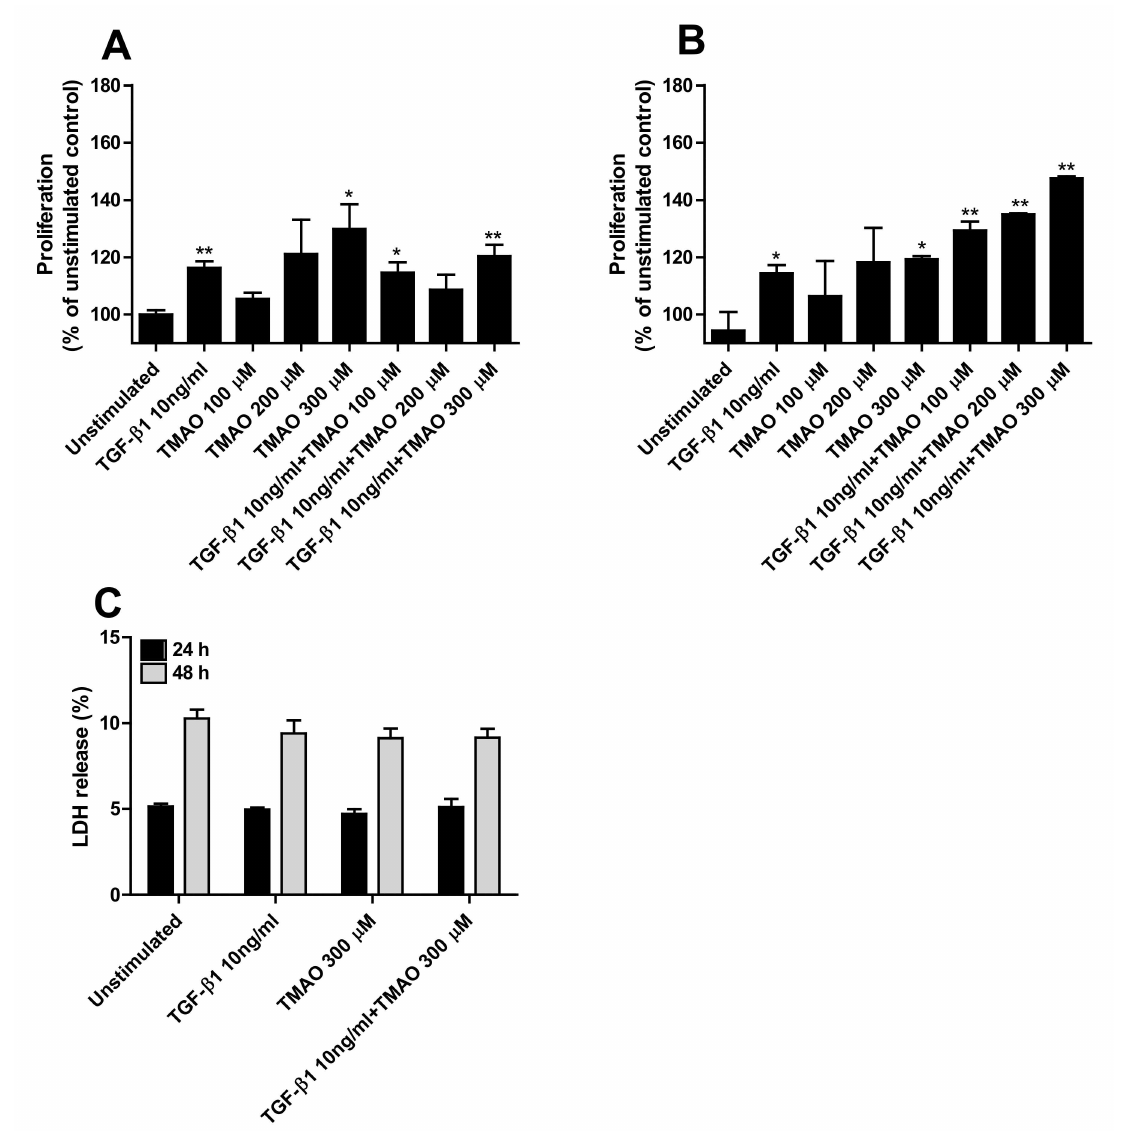
Figure 2. TMAO induces renal fibroblast proliferation. Renal fibroblasts were stimulated with 100–300 µ M TMAO and 10 ng/mL TGF- β 1 for 24 h ( A , C ) or 48 h ( B , C ) and proliferation ( A , B ) or LDH release ( C ) were evaluated. Proliferation is presented as % of unstimulated control. LDH release is presented as % of total LDH. Data are presented as mean ± SEM ( n = 3 independent experiments). Asterisks denote statistical significance compared to unstimulated cells (* p < 0.05, ** p <